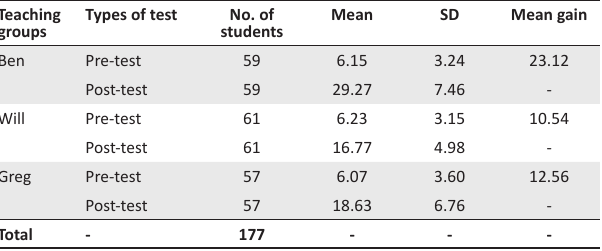
TABLE 1: Mean achievement scores and standard deviations of learners’ fraction achievement test scores in Ben, Will and Greg